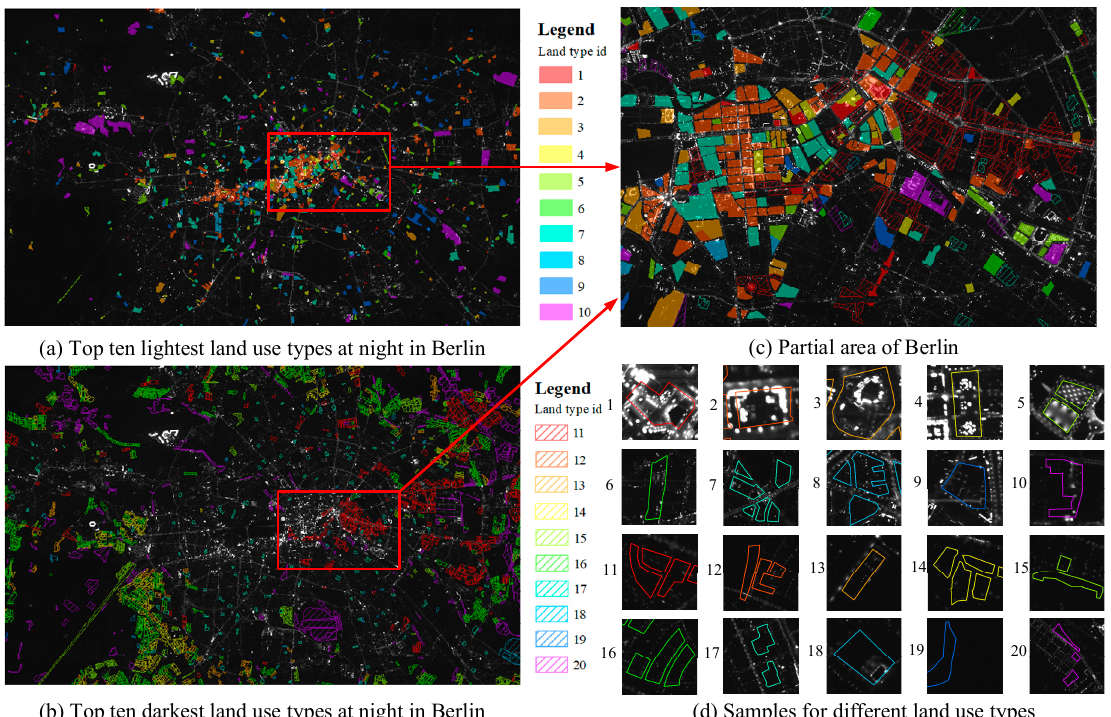
Figure 8. Top ten lightest and darkest land use types at night in Berlin.